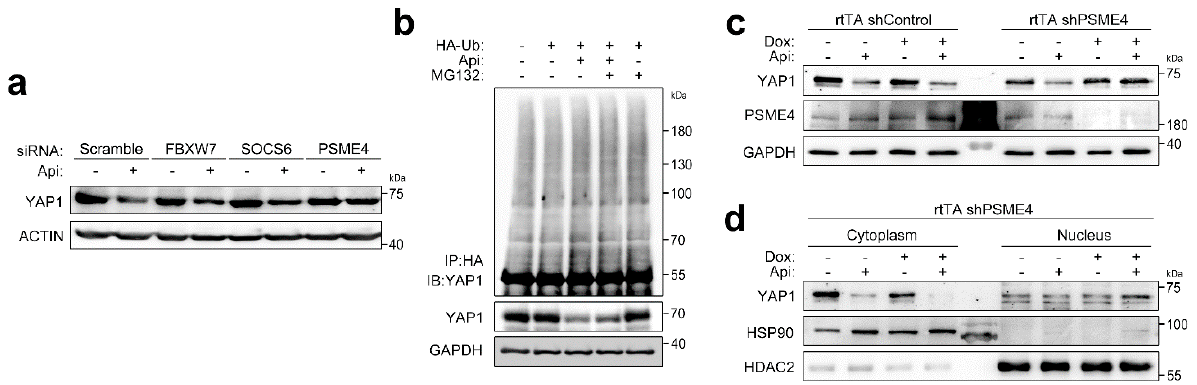
Figure 5. PSME4 degrades YAP1 in a polyubiquitination-independent manner. ( a ) Proteasome activator subunit 4 (PSME4) participates in YAP1 degradation in apicidin-treated cells. siRNA against F-box protein (FBXW) 7 or suppressor of cytokine signaling (SOCS) 6 failed to preserve acute loss of YAP1. A notable amount of YAP1 was visualized when PSME4 was targeted. ( b ) Apicidin did not induce YAP1 polyubiquitination. MG132 (25 µ M, 4 h) successfully mitigated YAP1 degradation but failed to induce YAP1 polyubiquitination. ( c ) PSME4 shRNA attenuated YAP1 degradation (seventh vs. eighth lane). ( d ) Preserved YAP1 mediated by PSME4 knockdown mainly accumulated in the nucleus (sixth vs. eighth lane). Gray circle: vehicle. Red square: apicidin. Two-way ANOVA with Tukey’s HSD post hoc test. Abbreviations: Ctrl, control. DOX, doxycycline. Ub, ubiquitin.